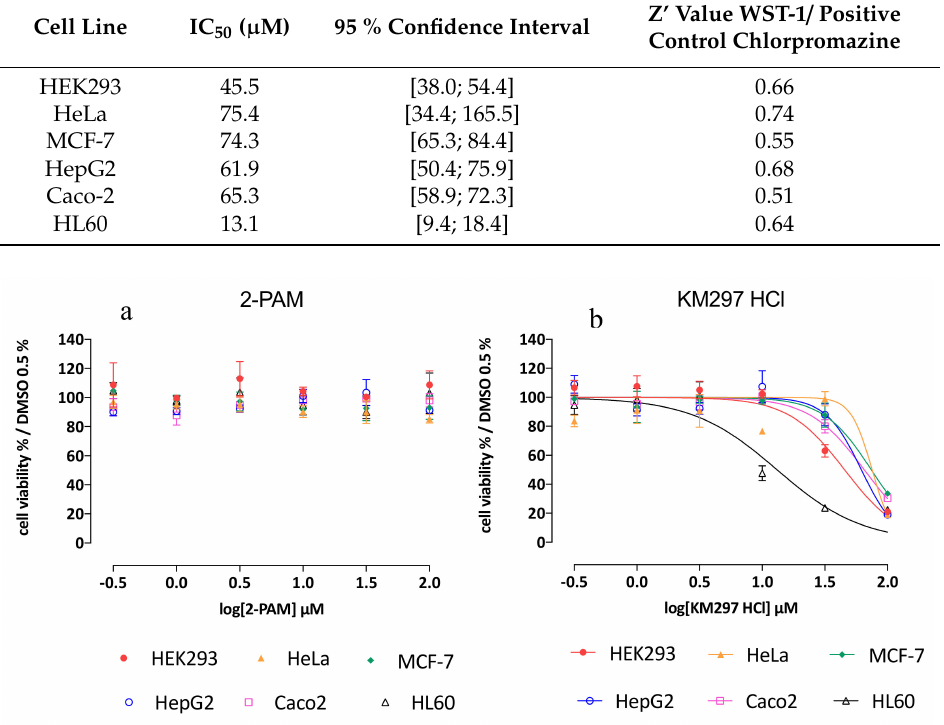
Figure 6. Cell viability WST-1 assay on 6 various cell lines (HEK293, HeLa, MCF-7, HepG2, Caco-2, and HL60 cells) after ( a ) 2-PAM and ( b ) KM297 HCl exposure. All experiments were carried out in triplicate and means ± SEM